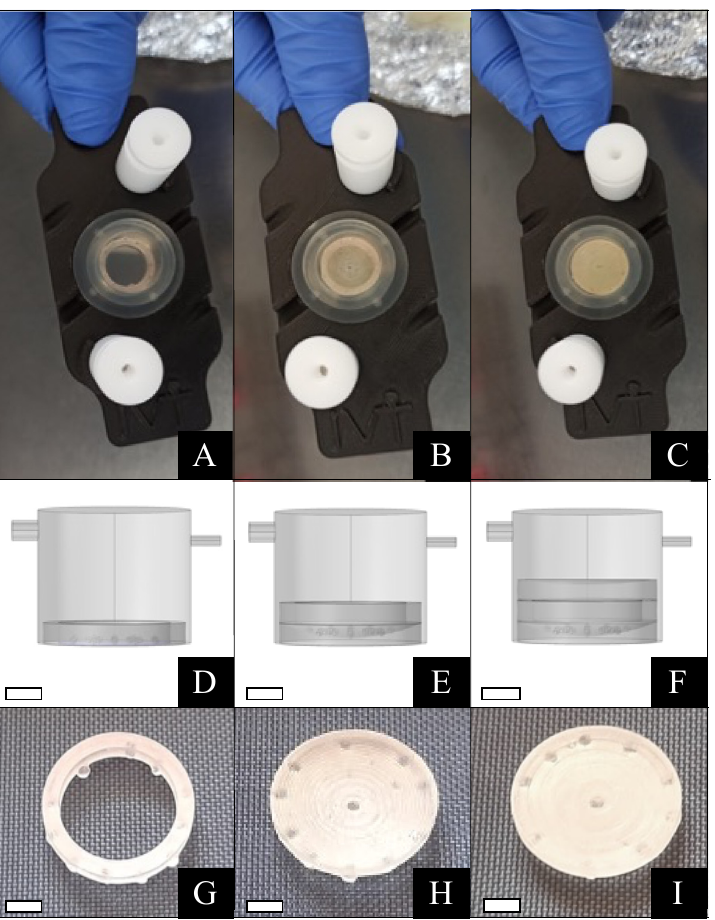
Figure 1. Set up of mIVM with biocompatible supports. In the higher section, an upper view of the bioreactor chamber with the ring ( A ), the concave + ring ( B ), and the completely assembled box support ( C ) at the bottom of the chamber. In the middle section, a schematic drawing of the bioreactor chamber set up with the ring support ( D ), the concave support with the ring on the top of it ( E ), and the assembled box ( F ) placed at the bottom of the chamber. In the lower section, close looks at the ring ( G ), concave ( H ), and plain disk ( I ) supports. Scale bars representing 3.5 mm for ( D – I )